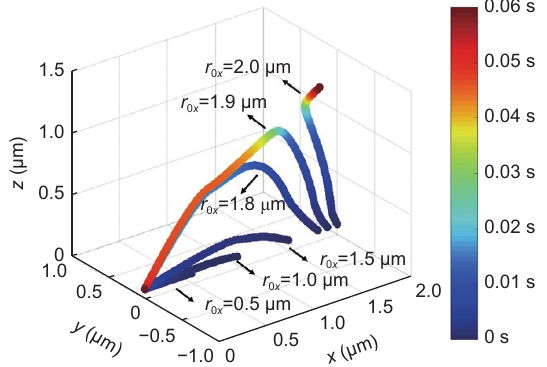
Fig. 4 | The 3D trajectories of the micro-sphere in the optical tweezers at different initial positions in the x -axis with r 0 x =0.5, 1.0, 1.5, 1.8, 1.9, and 2 μm .